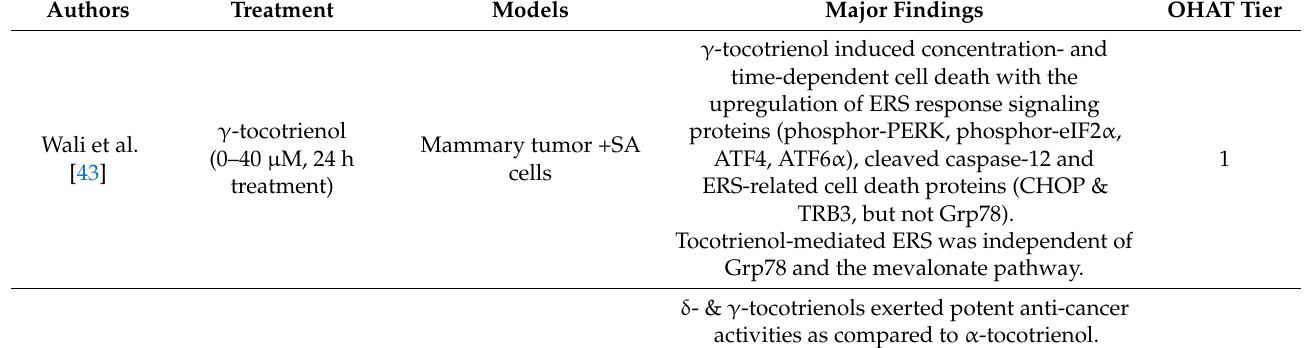
Table 1. Summary of information and findings of the included